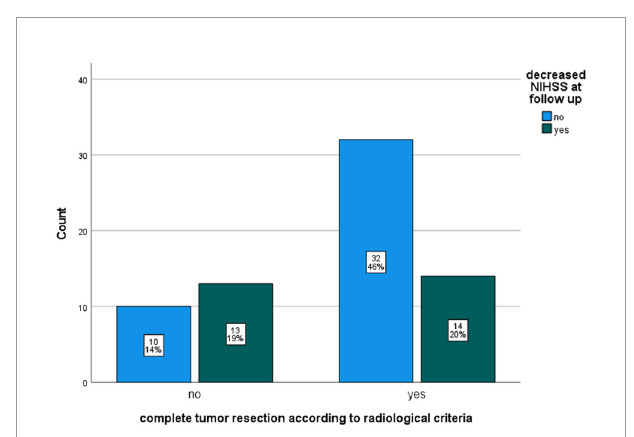
FIGURE 2 | Bar chart comparing proportions of decreased National institute of health score (NIHSS) at 3-month follow up compared to preoperative scores by complete tumor resection (CTR) according to radiological